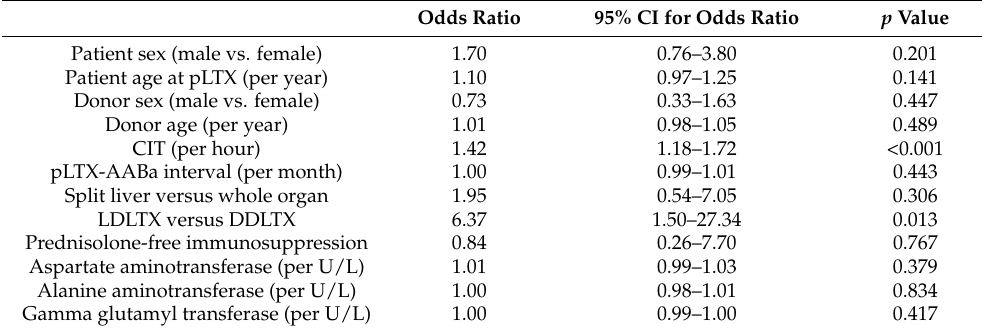
Table 3. Characteristics associated with ANA titer > 1:40 (odds ratios from binary logistic regression, mutually adjusted for all variables in the model, n = 142). Odds Ratio 95% CI for Odds Ratio p Value Patient sex (male vs. female)